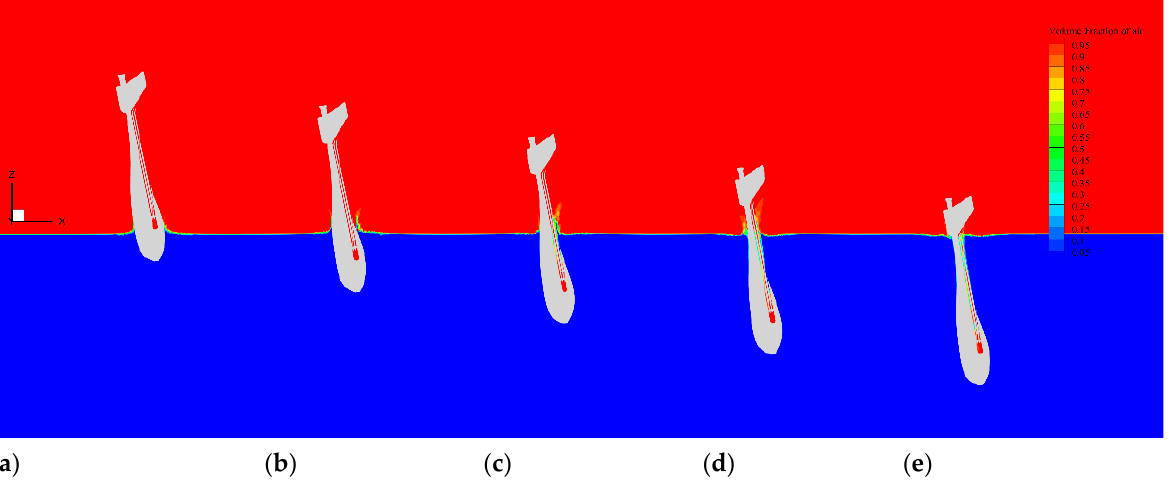
( e ) Figure 15. Free surface profiles of the vehicle entering water at θ 0 = 60° at different times: ( a ) t = 0.10 s, ( b ) t = 0.15 s, ( c ) t = 0.20 s, ( d ) t = 0.25 s, and ( e ) t = 0.30 s.